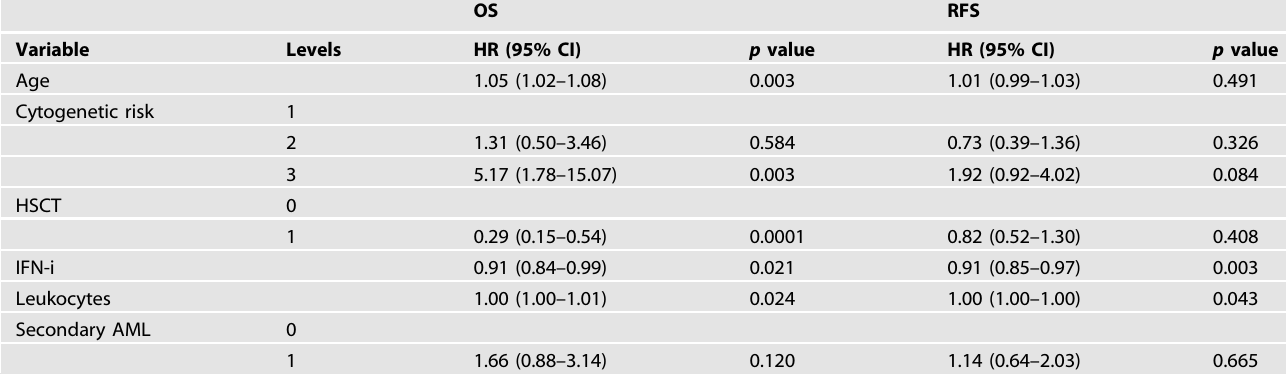
Table 3. Multivariate Cox proportional hazard